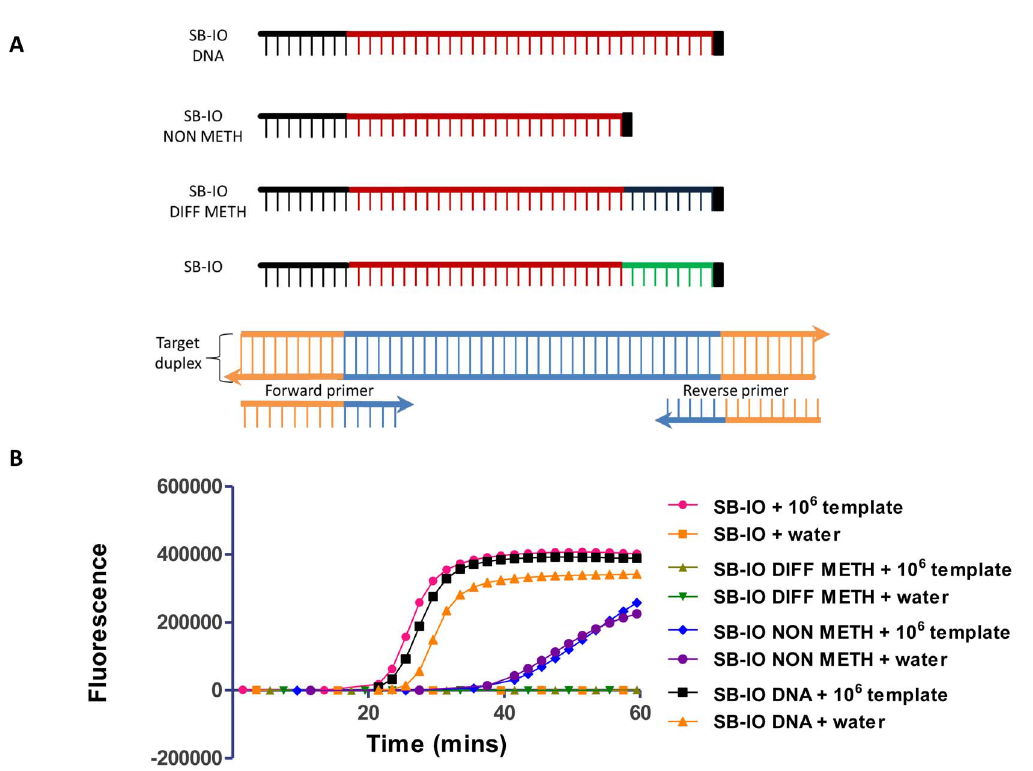
Figure 3. Artifactual amplification is abolished by using an invasion oligonucleotide (IO) with a 2 9 -O-methyl RNA modification. (A) Configuration of the IO molecules used. (B) Real-time monitoring of SIBA reactions with SYBR Green I using different IOs: (i) IO with a 2 9 -O-methyl RNA modification and fully homologous to the target duplex, SB-IO; (ii) IO fully homologous to the target duplex, where the 2 9 -O-methyl RNA modification was replaced with natural DNA nucleotides, SB-IO DNA; (iii) IO with a 2 9 -O-methyl RNA modification that is not homologous to the target duplex, SB-IO DIFF-METH; and (iv) IO with the 2 9 -O-methyl RNA modification deleted, SB-IO NON-METH. SB-F21 and SB-R21 were the forward and reverse primers, respectively. The reactions were either performed using 106 target template molecules (SB-template) or in the absence of